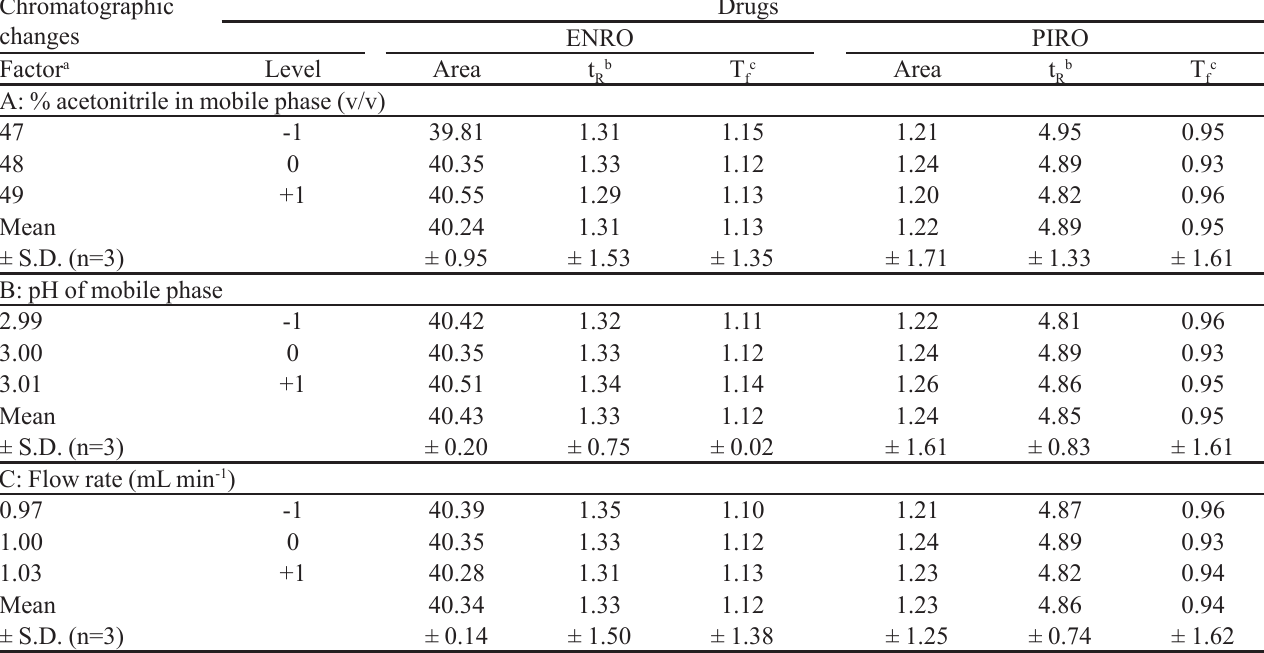
TABLE II - Robustness evaluation of the proposed HPLC method